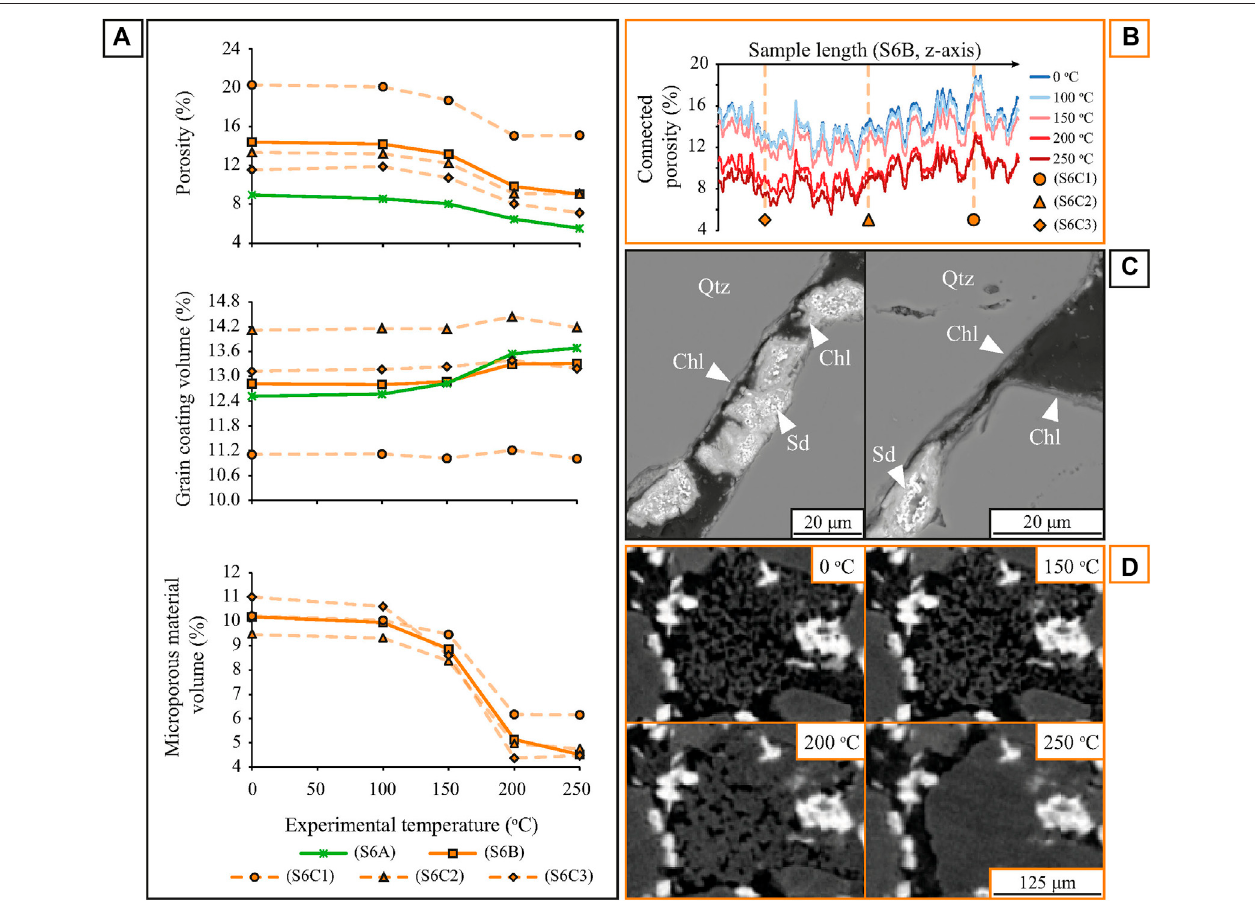
FIGURE 5 | Porosity, grain coating, and microporous volume evolution of sample S6 subjected to sequential hydrothermal treatment up to 250 ° C. (A) Porosity, grain coating, and microporous volume plots with increasing temperature of sample S6 at different resolutions and scales. Note that porosity and microporous volume decrease occurs, primarily, between 150 and 200 ° C followed by a stabilization phase. Grain coating increase is observed mainly on samples S6A and S6B at temperatures higher than 150 ° C. (B) Connected porosity distribution along sample length of sample S6B, color-coded per experimental temperature, with the position ofsamples S6C1-SC3 (i.e., cubic subvolumes) indicated along that length. Porosity reduction is evident between 150and 200 ° C. (C) Backscatter SEM images of the newly precipitated chlorite coatings associated with siderite dissolution. Where Chl = chlorite; Qtz = quartz; Sd = siderite. (D) 2D XCT images of the pore- fi lling kaolinite evolution destroying primary pore